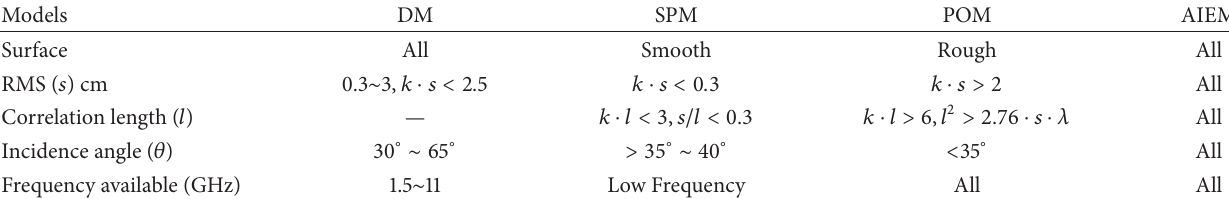
Table 2: Comparisons of Different Backscattering Coefficient